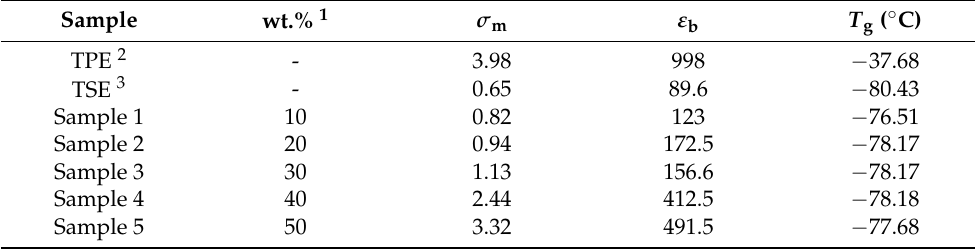
Table 1. The parameters of samples, wt.%, stress, strain and glass transition